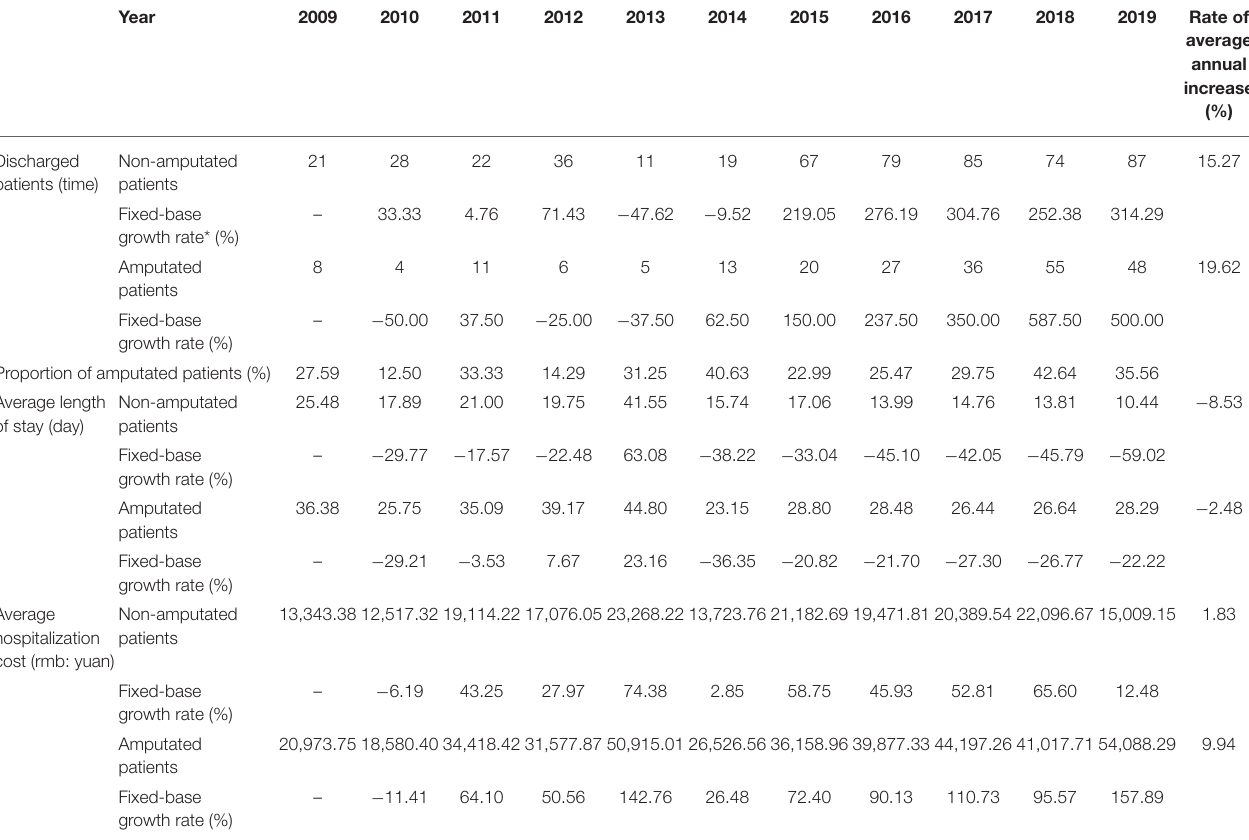
TABLE 4 | Comparison of indicators of diabetic patients with non-amputated and amputated patients from 2009 to